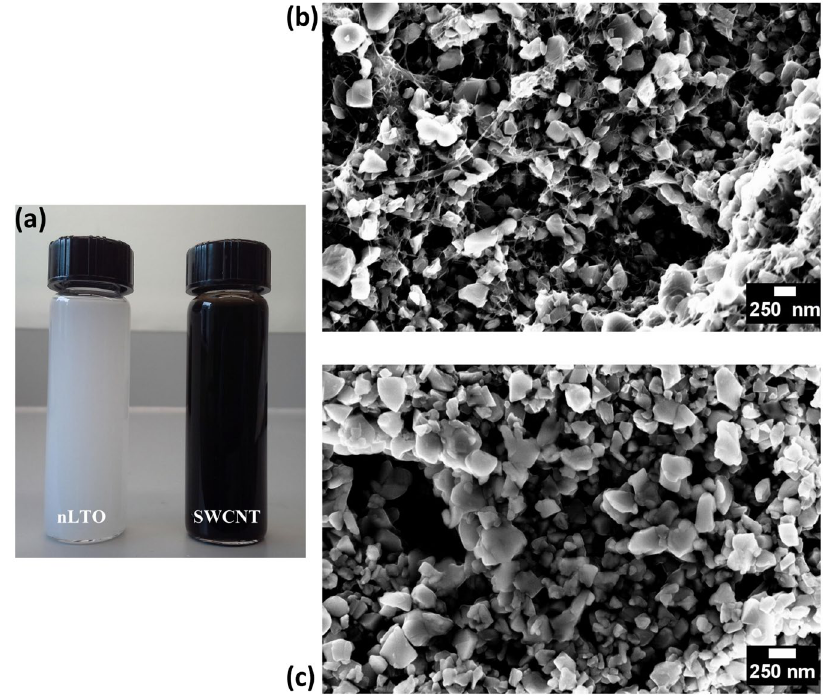
Figure 4. Samples of processed LTO and debundled carbon nanotubes (concentrations ~0.1 mg.mL − 1 ) ( a ) and representative SEM micrograph of nLTO/SWCNT ( b ) and nLTO ( c ) sprayed